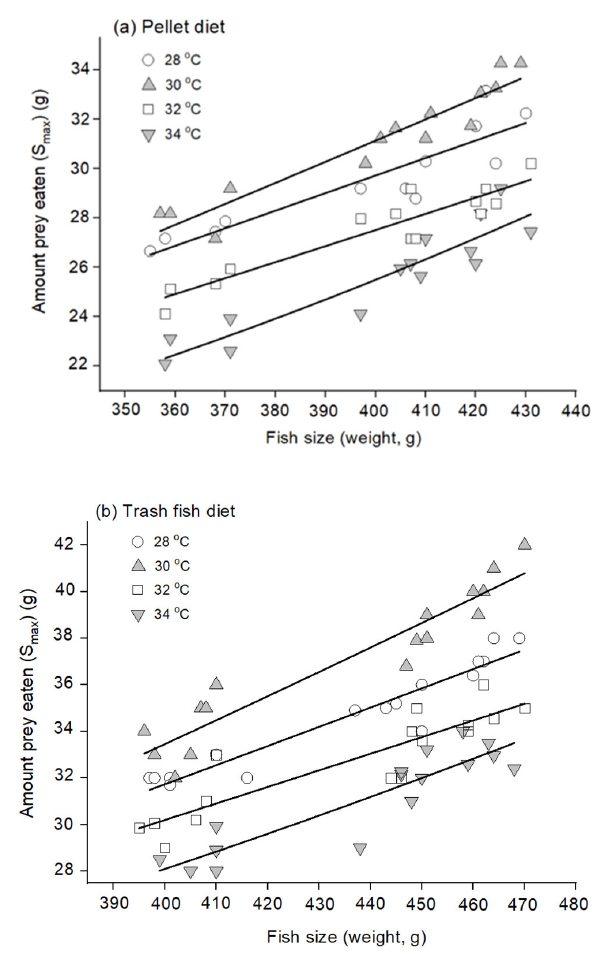
Figure 4. Relationship between the amount of satiation meal (S max , g wet weight) and size of fish (W, g) of the adult hybrid Sabah grouper fed with ( a ) pellet, and ( b ) trash fish diet at different